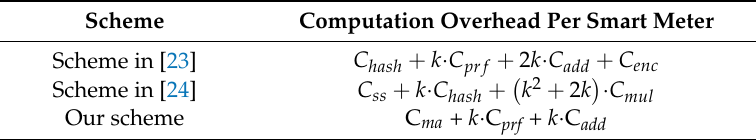
Table 3. Individual spatial computation overhead comparison